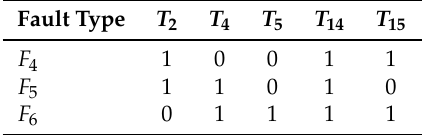
Table 7. Simplified dependency matrix of the case study in Experiment 1 after redundancy reduction.